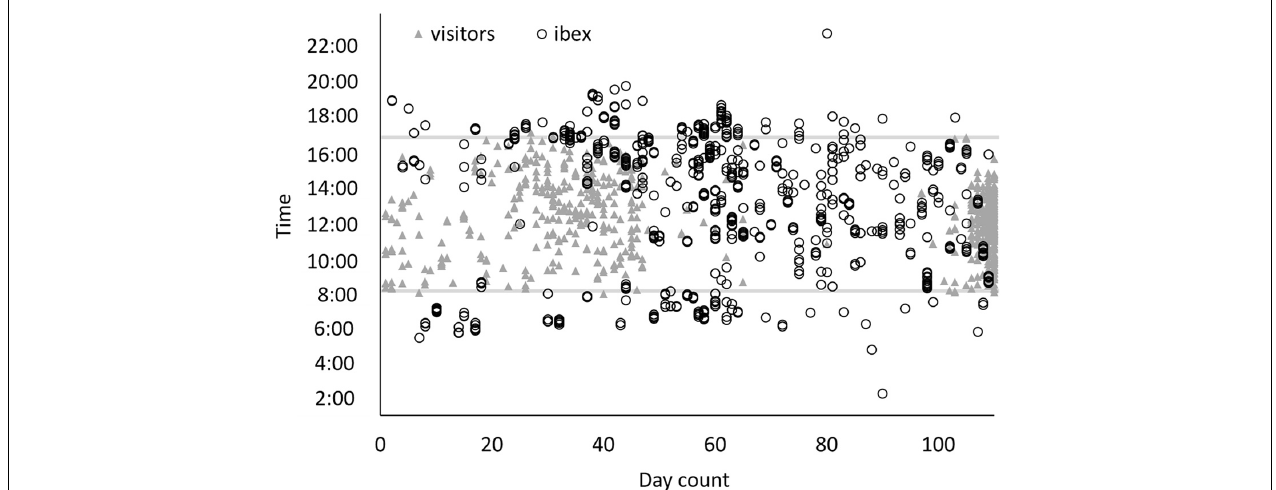
FIGURE 5 | Times that ibex (hollow black circles) and visitors (gray triangles) were spotted around the Pistacia atlantica (a popular location in the park for both humans and ibex). X -axis is the count of the days starting from July 14 to October 31, 2020. Gray lines represent the daily opening (bottom line) and closing (upper line) hours of Ein Avdat National Park. The site was under lockdown between days 67 and 97.